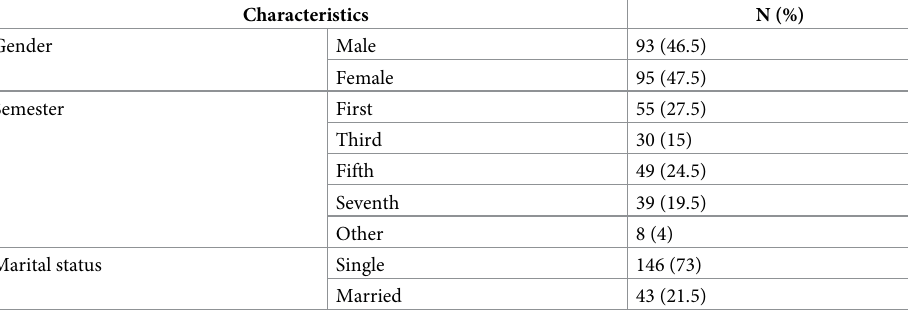
Table 1. Participants’ socio-demographic